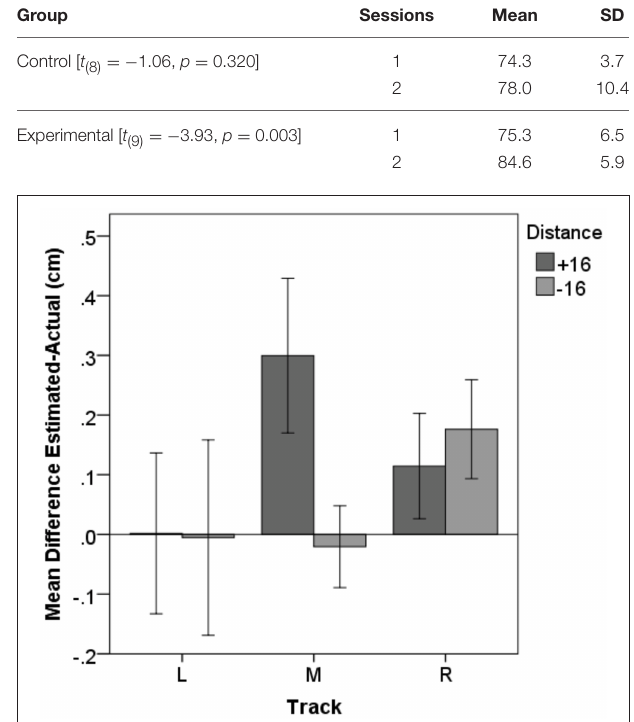
FIGURE 8 | Depth perception. Subjects were able to judge whether two objects were aligned with less than 0.5cm misestimating. For the middle track an effect of distance occurred, with participants’ estimation being significantly worse for objects presented further away. Error-bars represent 95% confidence